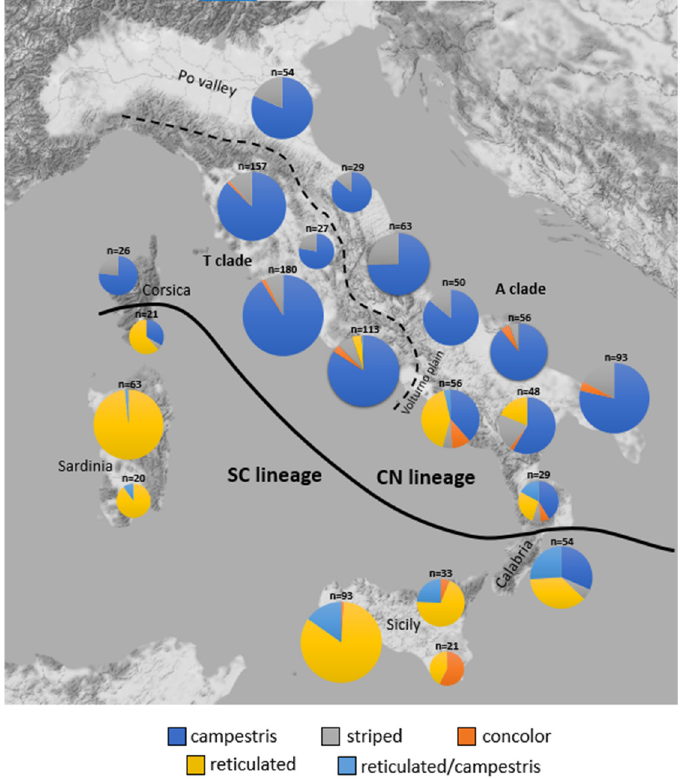
Figure 3. Geographical distribution of phenotypic frequencies and mtDNA lineages/clades of Podarcis siculus in Italy.